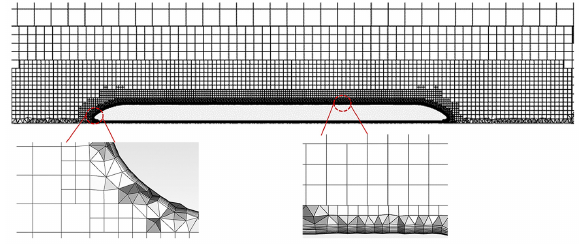
Fig. 3. Configuration of the computational mesh.